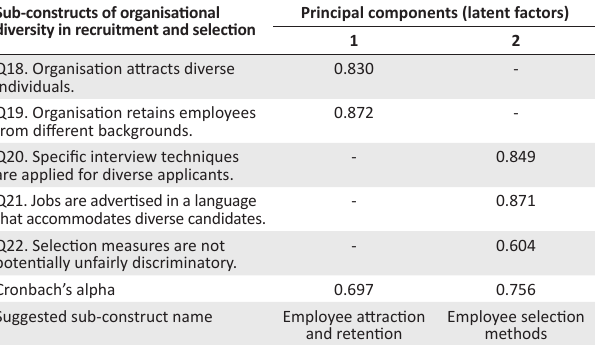
TABLE 5: Exploratory factor analysis of organisational diversity in recruitment and selection. Sub-constructs of organisational diversity in recruitment and selection